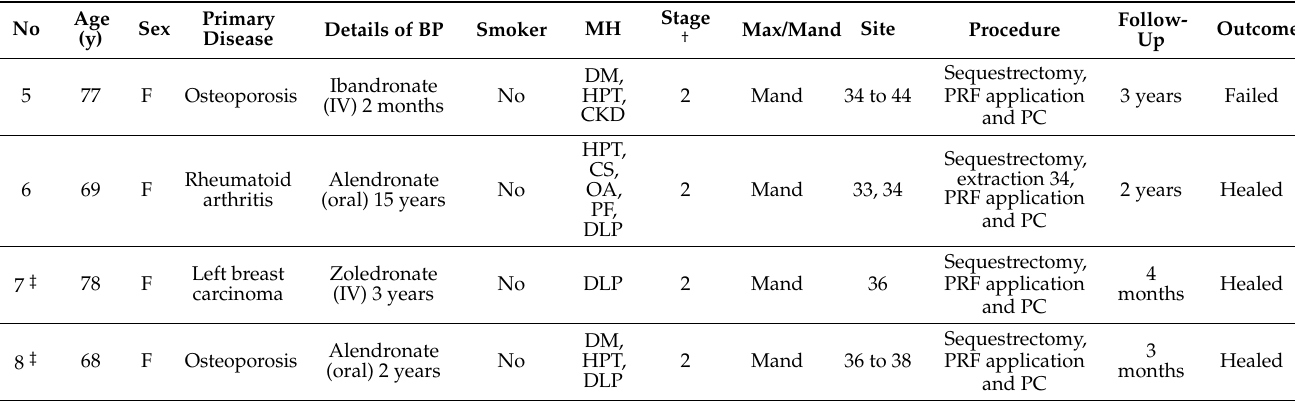
Table 3. Clinical characteristics of patients with medication-related osteonecrosis of the jaws (MRONJ) treated with PRF as